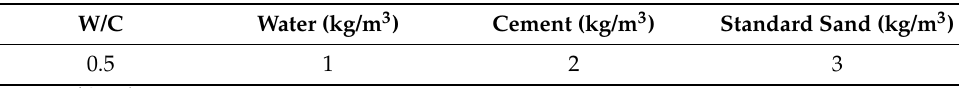
Table 2. Mix proportion.